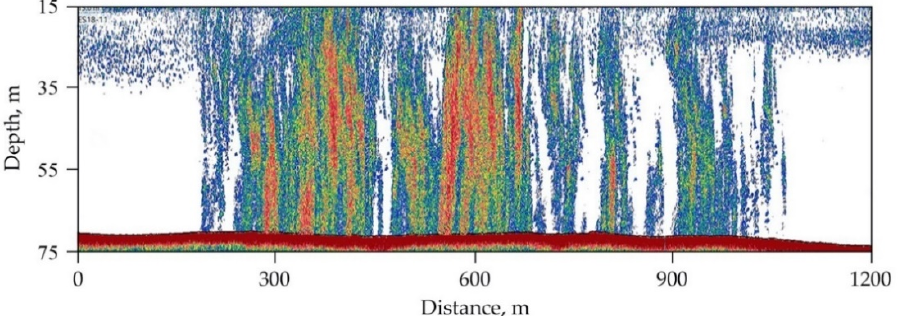
Figure 1. Sonar cross-section of seeps in the Arctic shelf.